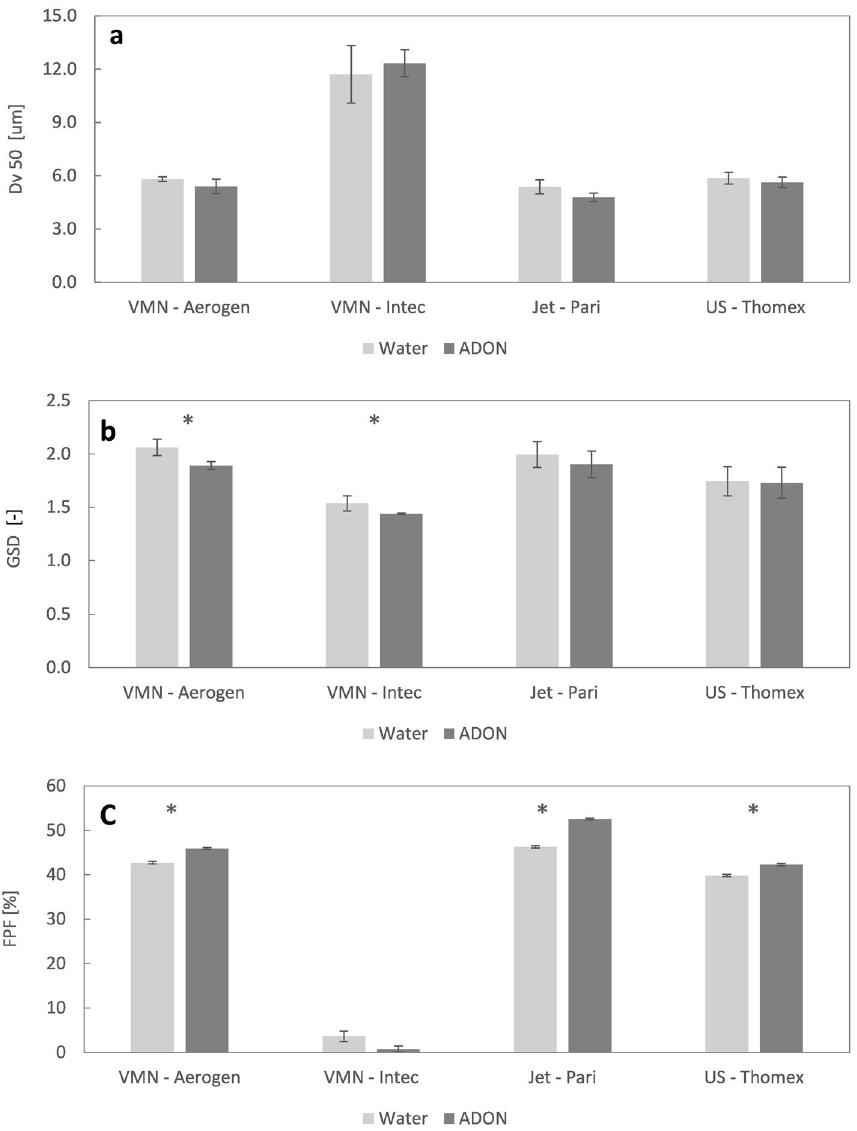
Figure 3. Properties of ADONs and water mists emitted from selected nebulizers: ( a ) Dv50 , ( b ) GSD, ( c ) FPF. Mean values (n = 3) + standard deviation (error bars). Single asterisks denote the statistically significant differences between samples for the same nebulizer for α = 0.05